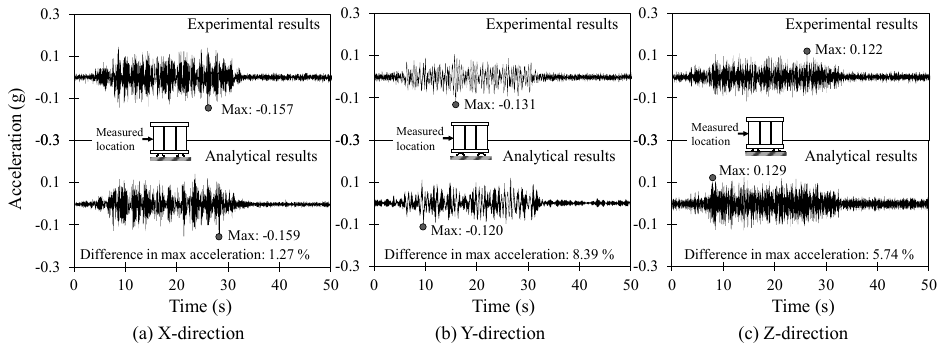
Figure 5. Comparison of acceleration time history responses between analytical and experimental results for AC156_25.